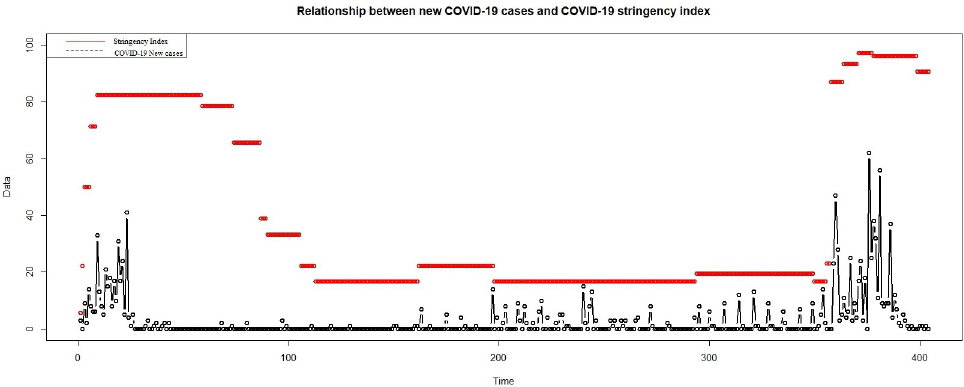
Fig 3. The relationship between new COVID-19 cases and COVID-19 stringency